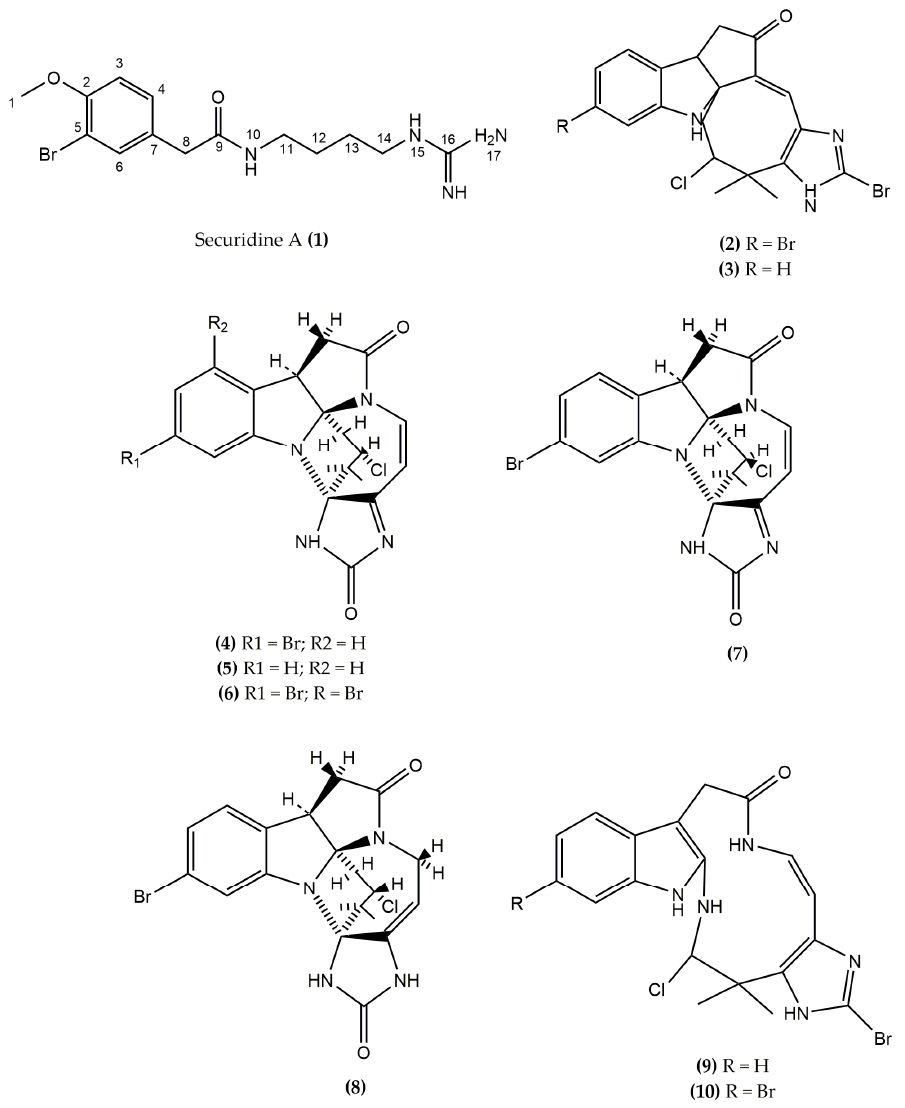
Figure 1. Structure of novel compound Securidine A ( 1 ), Securamine A–G ( 2 – 8 ), and Securines A and B ( 9 – 10 ).